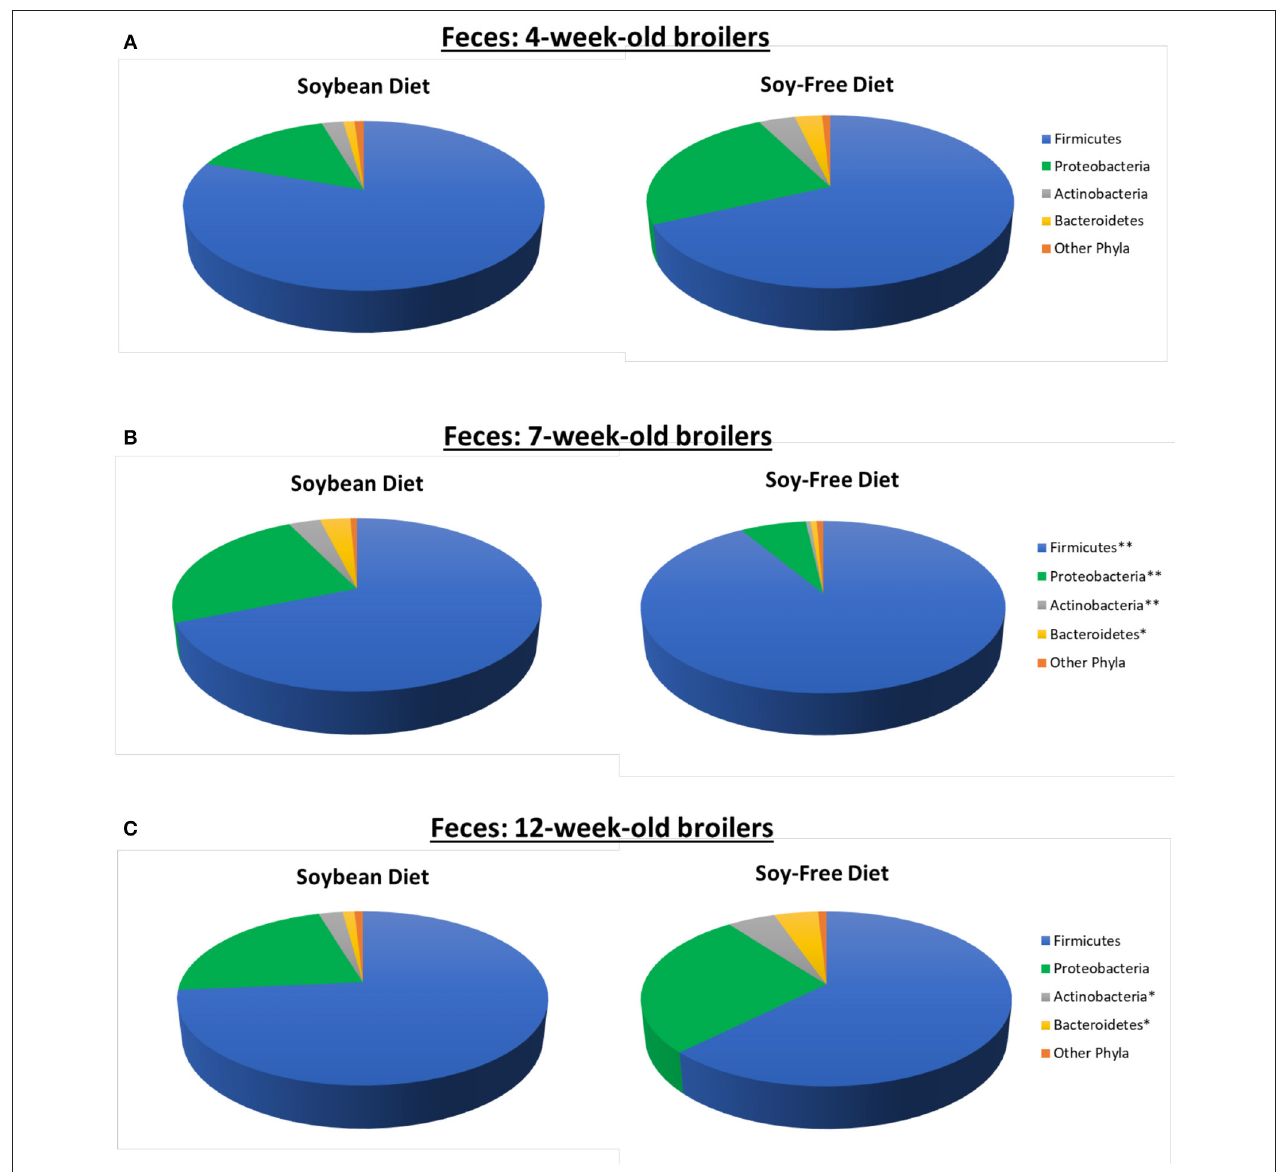
FIGURE 1 | Relative abundance of major bacterial phyla ( ≥ 0.5% of all OTUs recovered) of pasture-raised broilers fed Soybean or Soy-Free Diets, at different stages along the farm-to-fork continuum. (A) Fecal samples obtained from 4-week-old pasture-raised broilers; (B) Fecal samples obtained from 7-week-old pasture-raised broilers; (C) Fecal samples obtained from 12-week-old pasture-raised broilers. * Differences were significant at the P ≤ 0.05 level. ** Differences were significant at the P ≤ 0.001